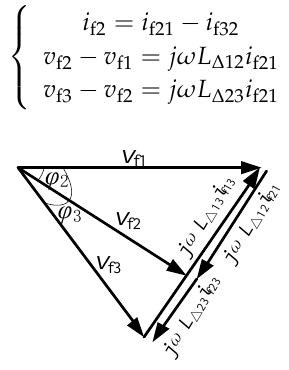
Figure 5. Simplified fundamental equivalent circuit of three-port active bridge (TAB) ( a ) Y-type primary referred circuit; ( b ) △ -type primary referred circuit.